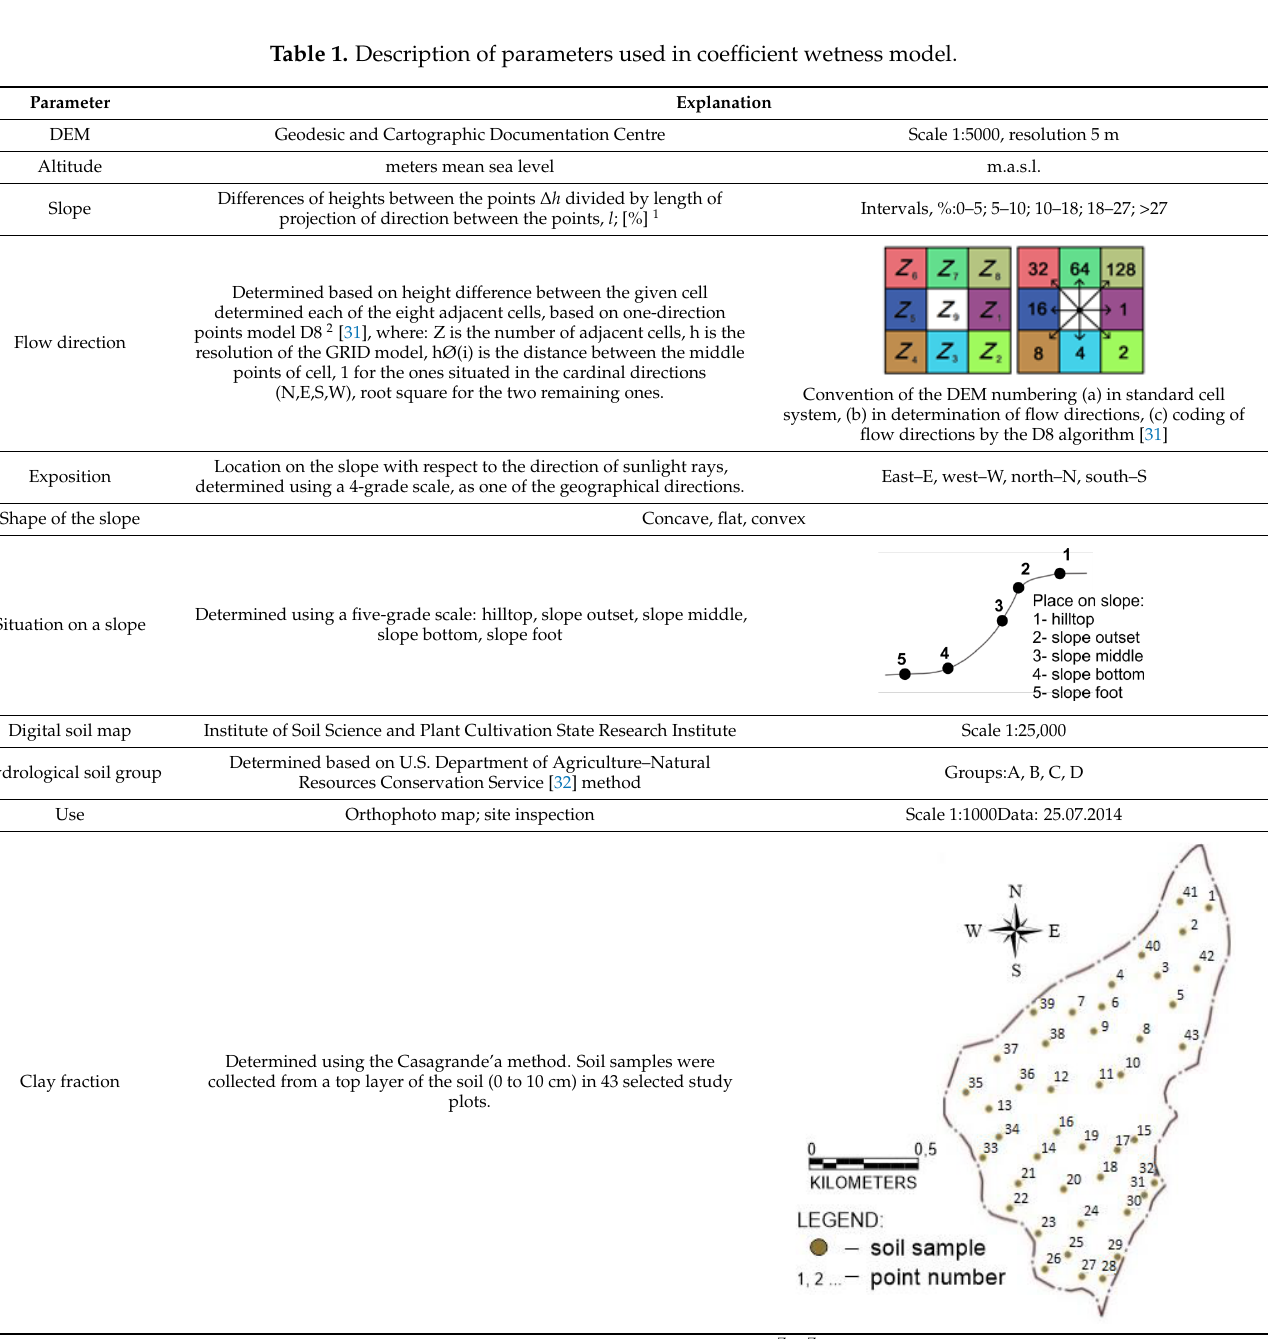
Table 1. Description of parameters used in coefficient wetness